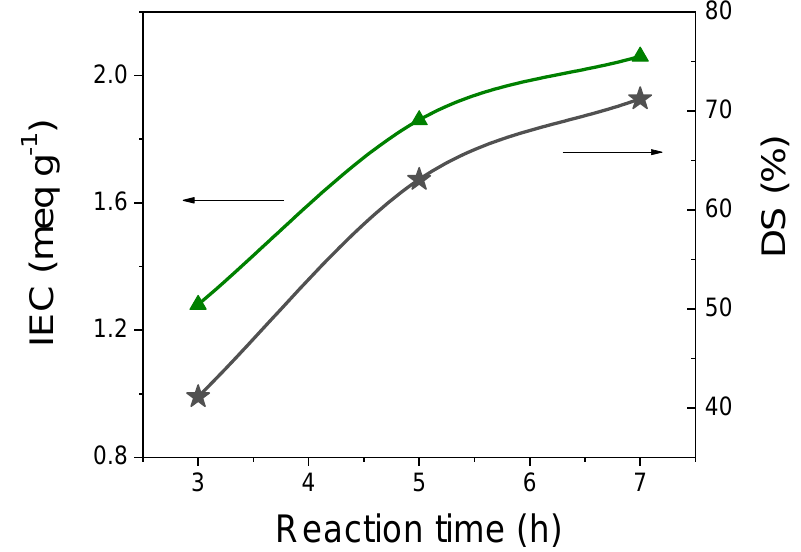
Figure 1. E ff ect of the reaction time on the IEC (meq g − 1 ) and DS (%) of Figure 1. Effect of the reaction time on the IEC (meq g −1 ) and DS (%) of sPEEK.